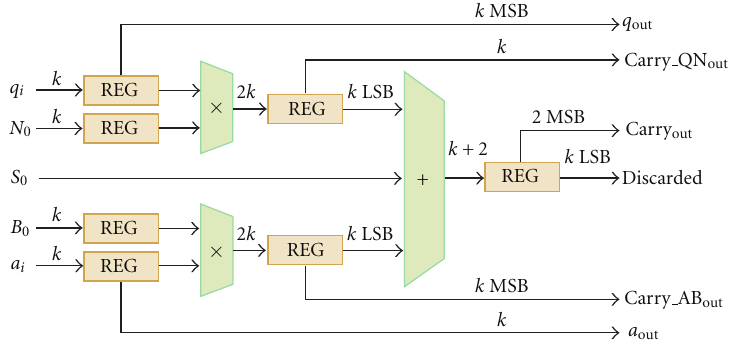
Figure 3: First Processing Element internal architecture.